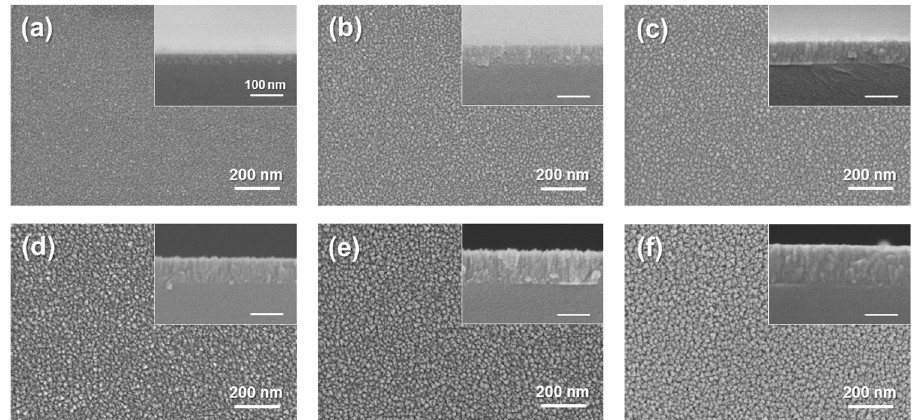
Figure 2. SEM surface morphology of TiN thin film deposited with various source power: ( a ) 50 W, ( b ) 75 W, ( c ) 100 W, ( d ) 125 W, ( e ) 150 W, and ( f ) 175 W, respectively. The inset presents a SEM image of TiN thickness.